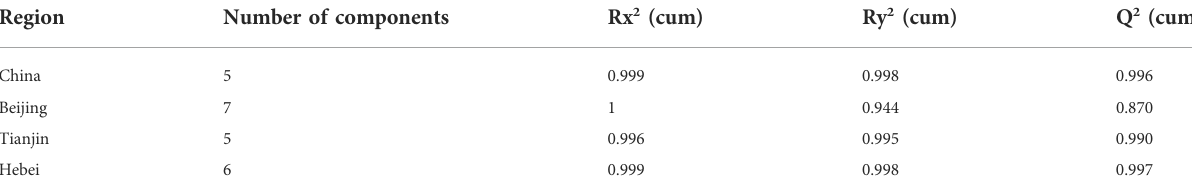
TABLE 3 Cross-validation of